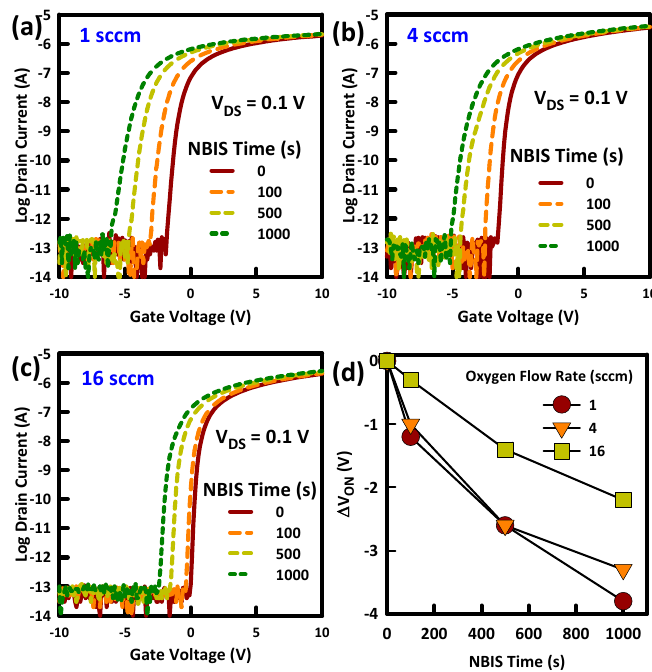
Figure 11. ( a – c ) Thin-film transistor (TFT) current-voltage ( I - V ) characteristics before and after negative-gate bias stress combined with visible light illumination (NBIS) for varying oxygen partial pressure during the deposition of the amorphous indium-gallium zinc-oxide layer. ( d ) The corresponding NBIS-induced negative turn-on voltage ( V ON ) shifts.